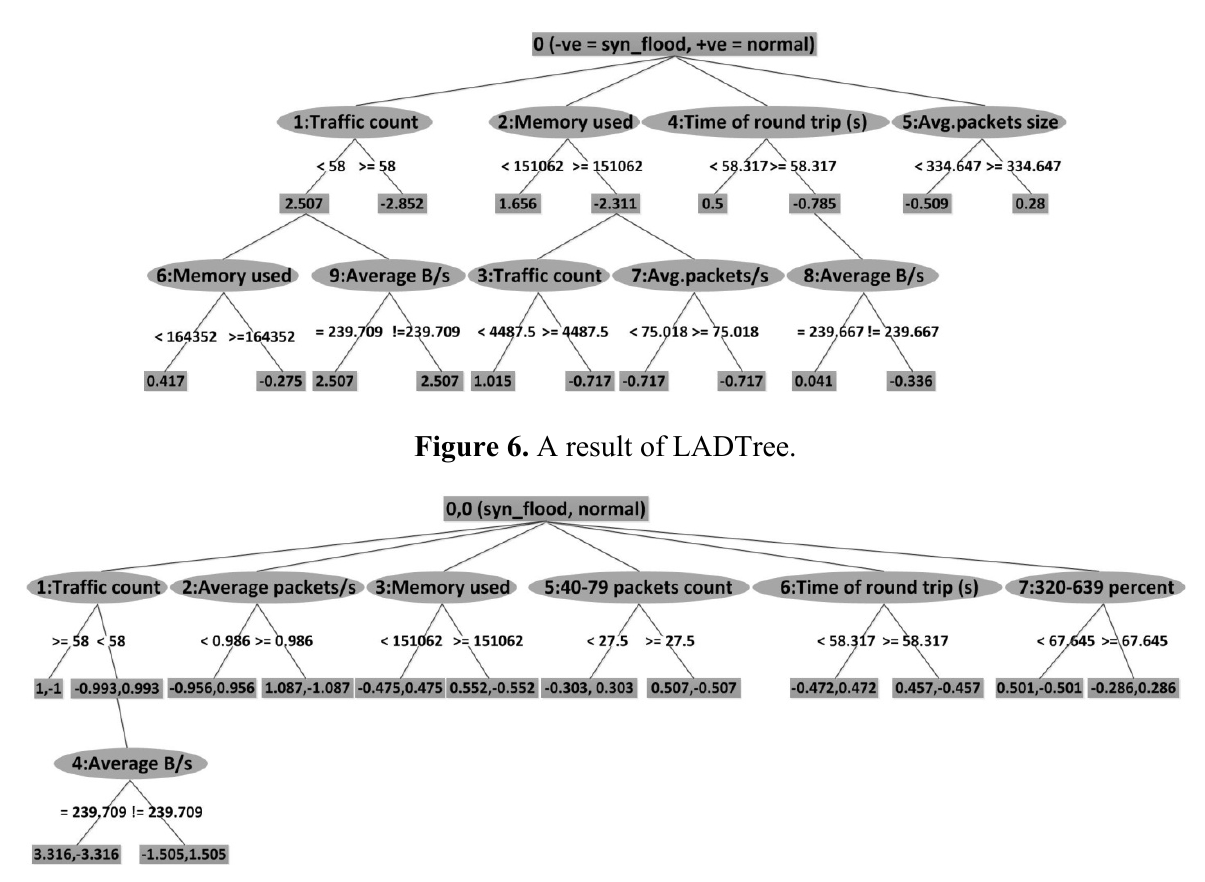
Figure 5. A result of ADTree.